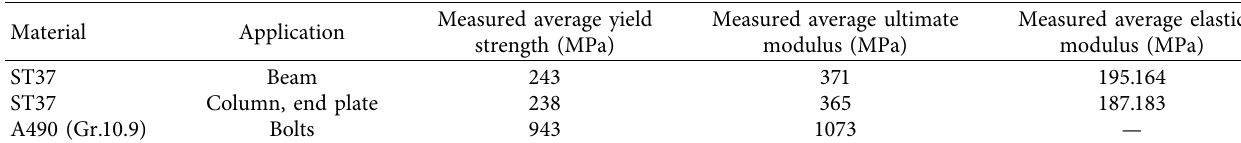
Table 2: Mechanical properties of the used